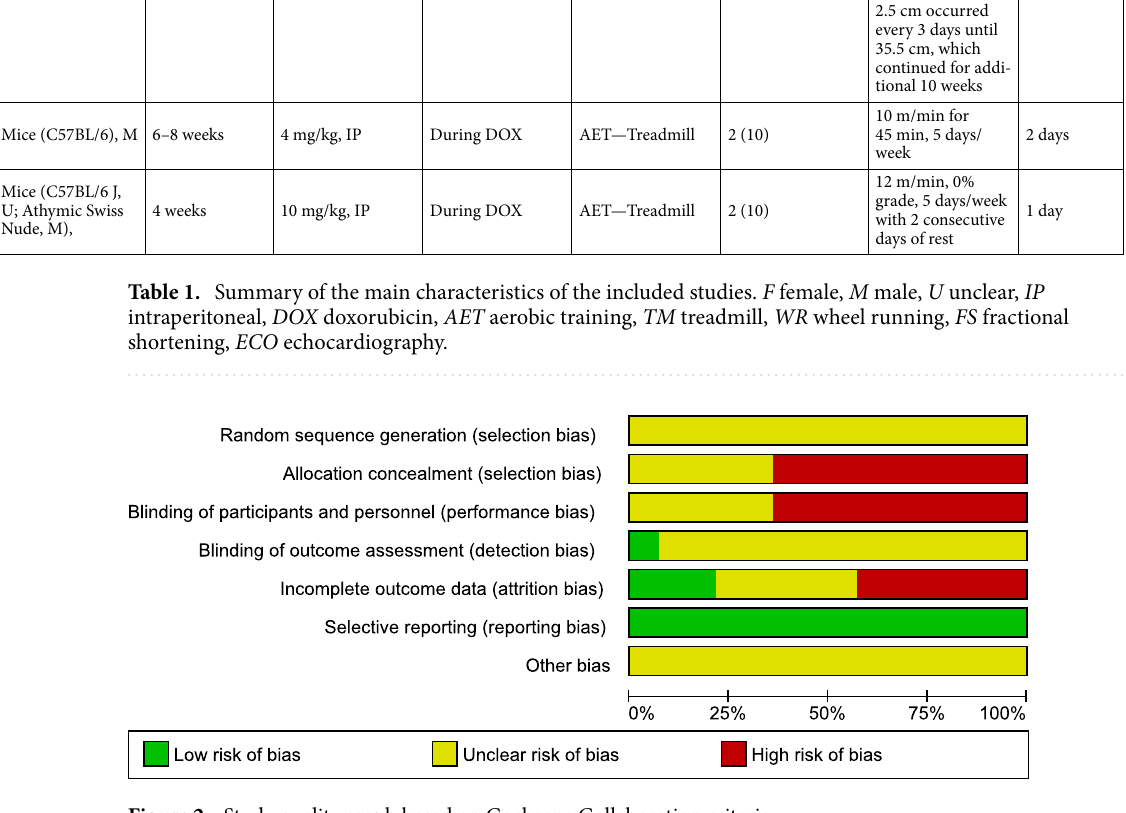
Figure 2. Study quality graph based on Cochrane Collaboration